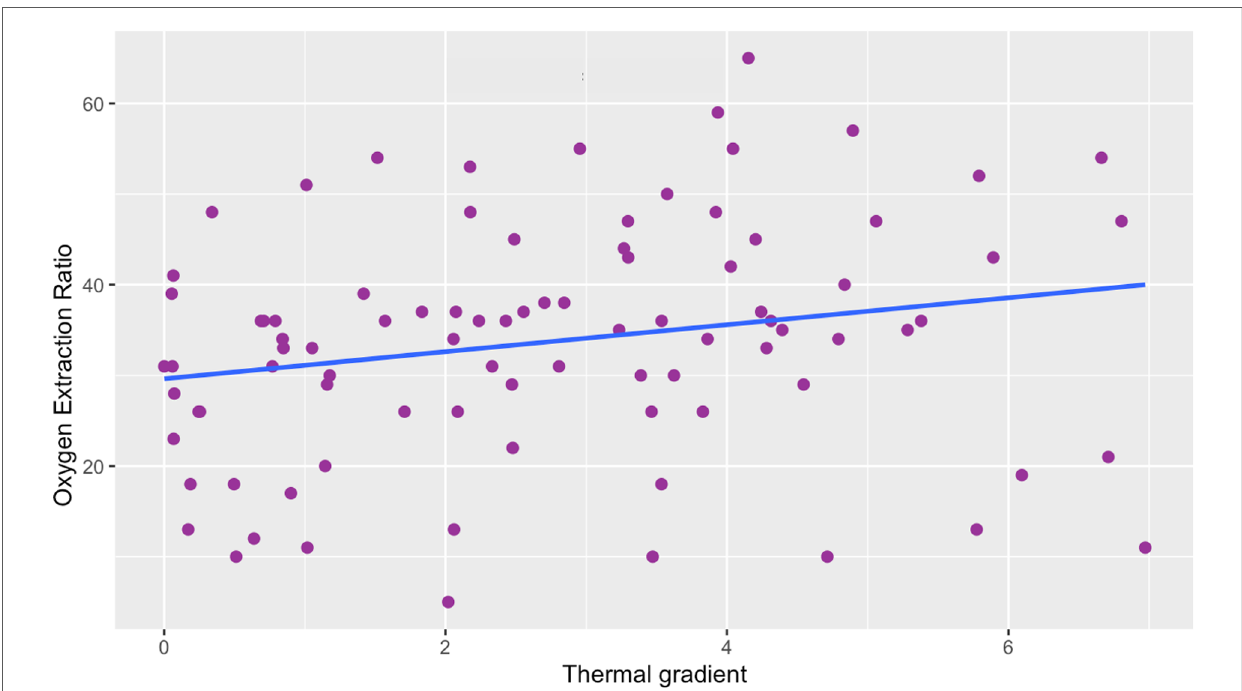
FIGURE 3 Scatter plot of thermal gradient vs. oxygen extraction ratio. There is a weak correlation between the thermal gradient and the O 2 ER. Thermal gradient is expressed in °C, Oxygen Extraction Ratio is expressed in %. Spearman correlation coef fi cient was p =0.25, p =0.016.